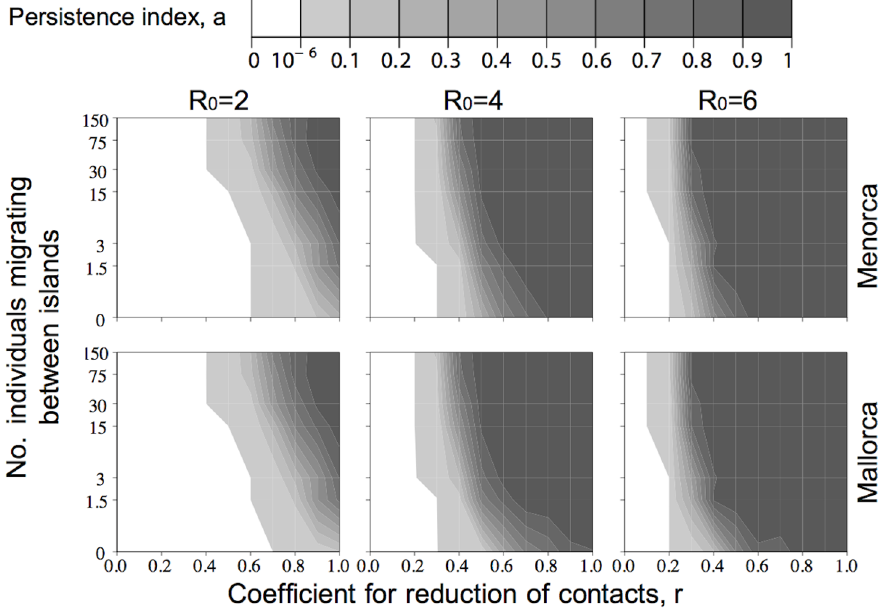
Figure 6. Ecological factors effect in EBLV-1 persistence on both islands. The persistence index is represented as a function of the seasonal interisland exchanges ( Y -axes) and reduction of contacts during low-transmission periods ( X -axes), for three different intraspecies R 0 values (2, 4 and 6). Persistence index shades of gray from white to black correspond, respectively, to low and high probabilities of virus persistence.